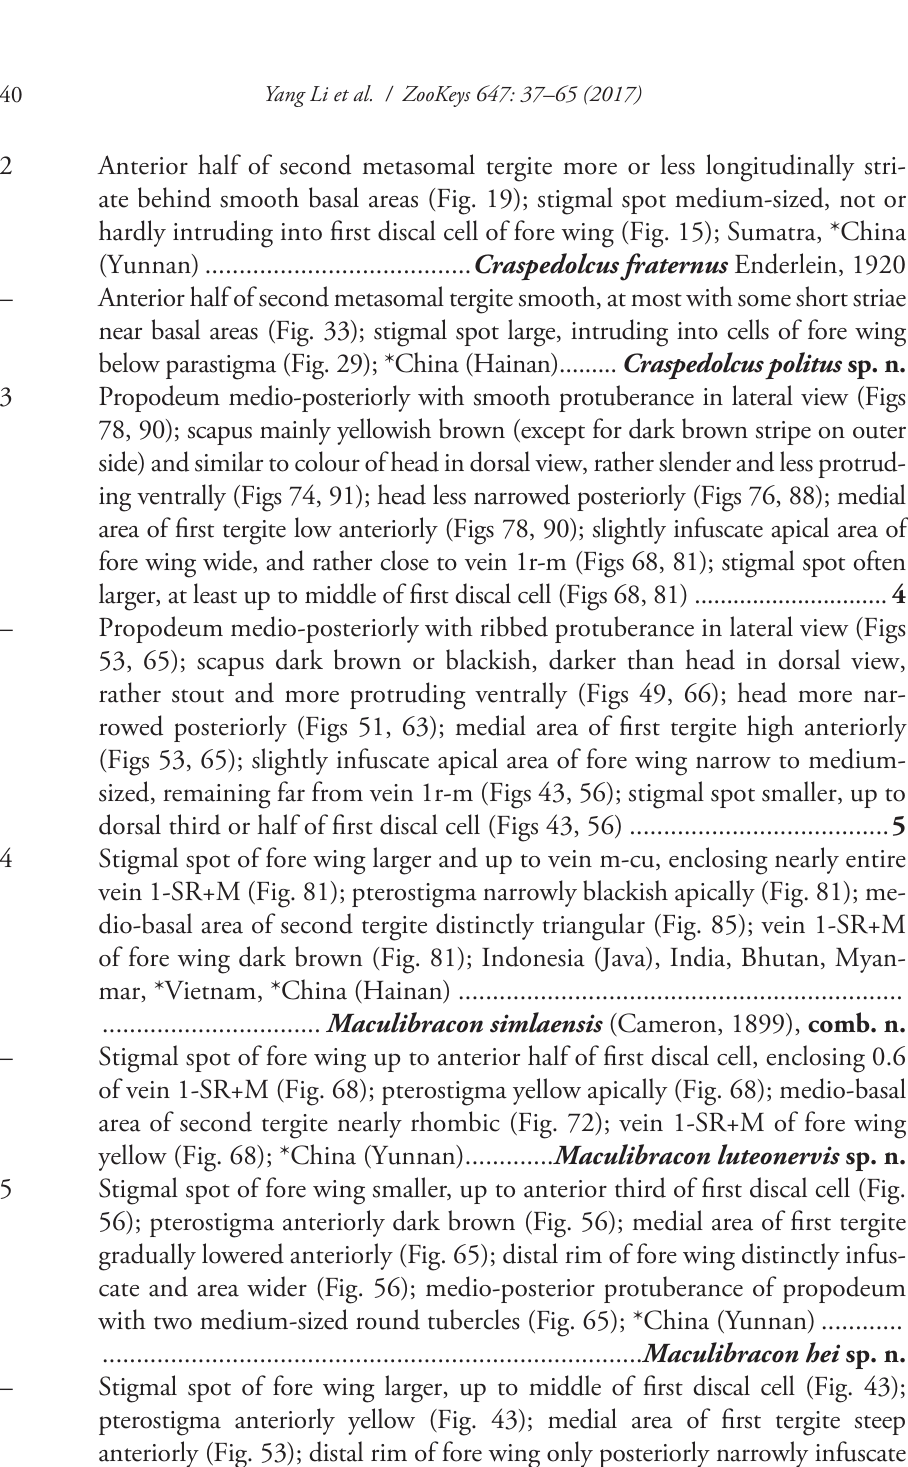
of vein 1-SR+M (Fig. 68); pterostigma yellow apically (Fig. 68); medio-basal area of second tergite nearly rhombic (Fig. 72); vein 1-SR+M of fore wing yellow (Fig. 68); *China (Yunnan) ............. Maculibracon luteonervis sp. n. Stigmal spot of fore wing smaller, up to anterior third of first discal cell (Fig. 56); pterostigma anteriorly dark brown (Fig. 56); medial area of first tergite gradually lowered anteriorly (Fig. 65); distal rim of fore wing distinctly infus- cate and area wider (Fig. 56); medio-posterior protuberance of propodeum with two medium-sized round tubercles (Fig. 65); *China (Yunnan) ............ – Stigmal spot of fore wing larger, up to middle of first discal cell (Fig. 43); pterostigma anteriorly yellow (Fig. 43); medial area of first tergite steep anteriorly (Fig. 53); distal rim of fore wing only posteriorly narrowly infuscate (Fig. 43); medio-posterior protuberance of propodeum with small round tubercle anteriorly followed by two short transverse crests (Fig. 53);